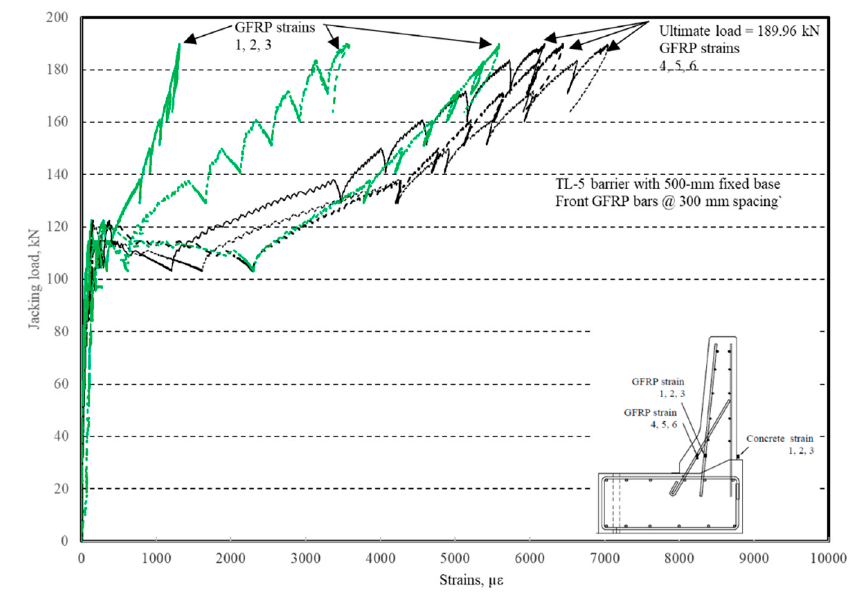
Figure 24. Specimen # 4: Load vs. GFRP bar strain history.